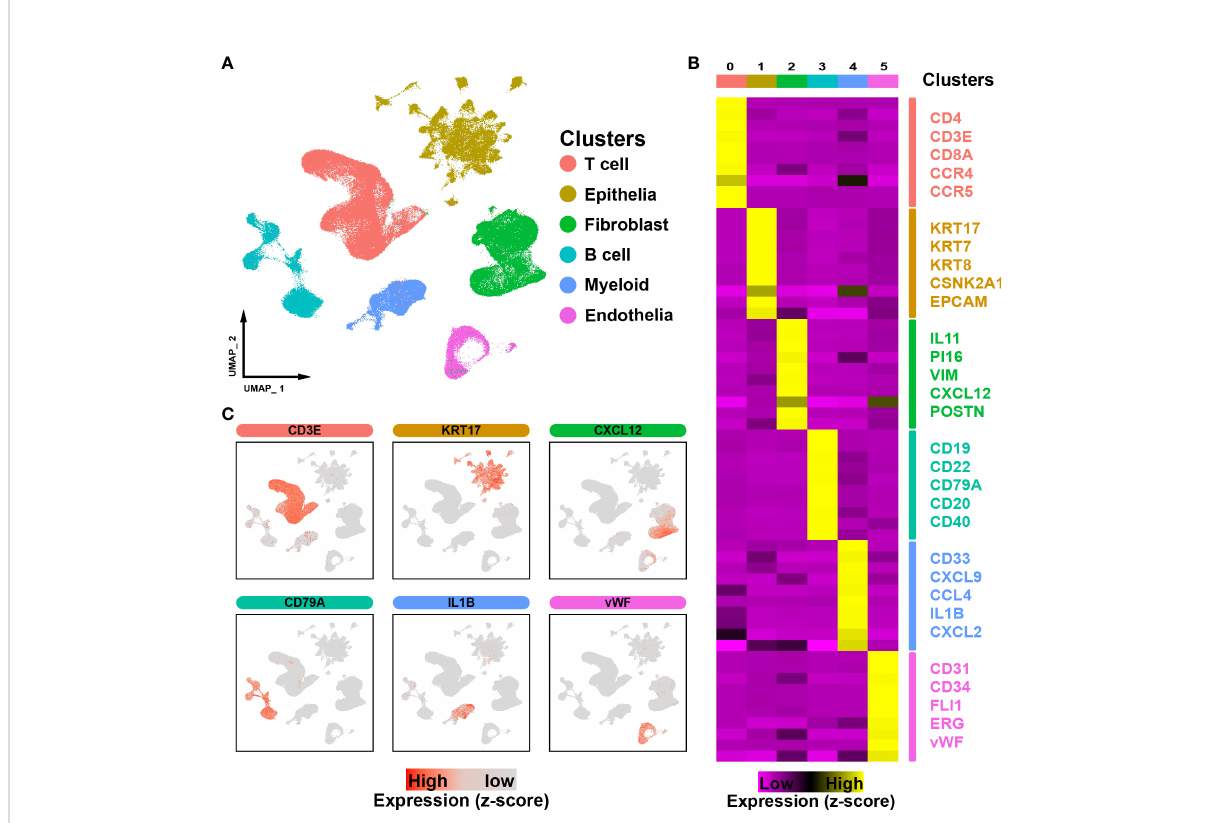
FIGURE 1 ScRNA-seq pro fi ling of ESCC microenvironments. (A) . The UMAP plot visualizes the cell types in the ESCC microenvironment, with each cell type represented by a different color. (B) . Heatmap showing the expression of marker genes in the different cell types. (C) . UMAP plot showing the expression levels of marker genes for different cell